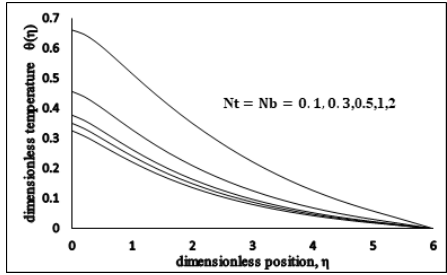
Figure 12. Dimensionless Temperature vs Nt and Nb .